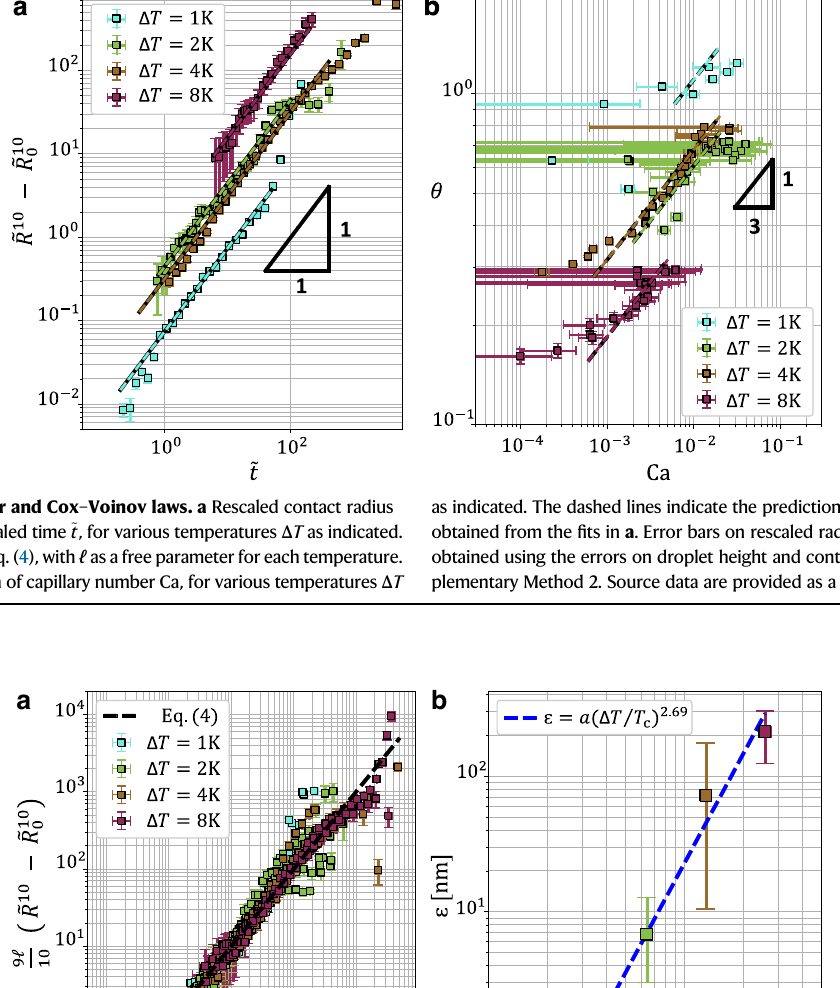
b Extracted precursor- fi lm thickness ϵ as a function of the temperature distance Δ T to the critical point, as obtained by fi tting individual experimental pro fi les to numerical solutions of Eq. (1) (see Fig. 2 c and d ). The dashed line indicates the (cid:1) (cid:3) 2 : 69 with a =5.54mm. Error bars on precursor- fi lm empirical power law ϵ = a Δ T = T c thickness correspond to the maximum acceptable values to fi t numerical pro fi les with the experimental ones. Source data are provided as a Source Data fi le.